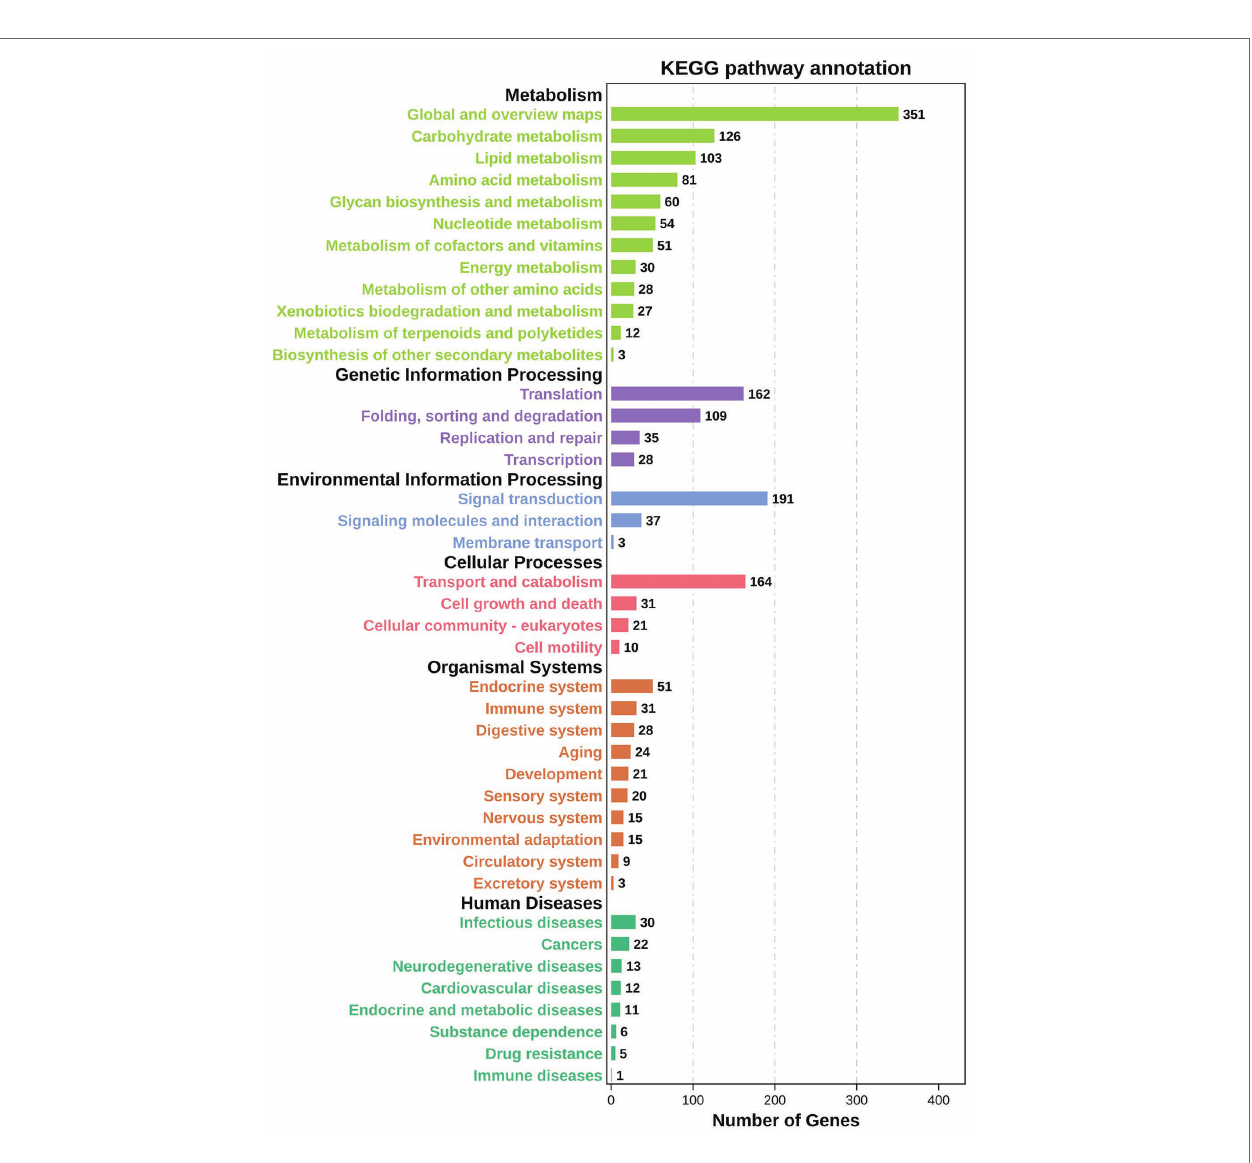
FIGURE 6 | KEGG enrichment analyses of DEGs in TWS119 fed and control P. vannamei . Highly expressed biological pathways represented in the transcriptome retrieved from the KEGG database. DEGs were assigned to six special KEGG pathways, including organismal systems, metabolism, genetic information processing and environmental information processing, cellular processes, and human